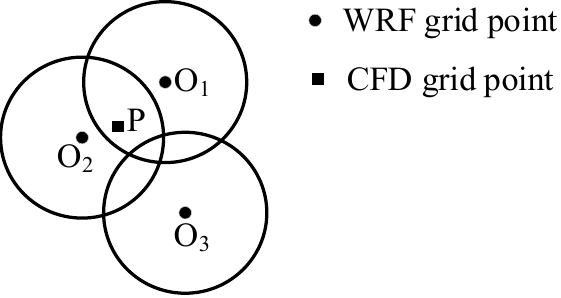
Figure 4. Sketch map of Cressman interpolation function. WRF and CFD grid points are all on the lateral boundary of the CFD domain.